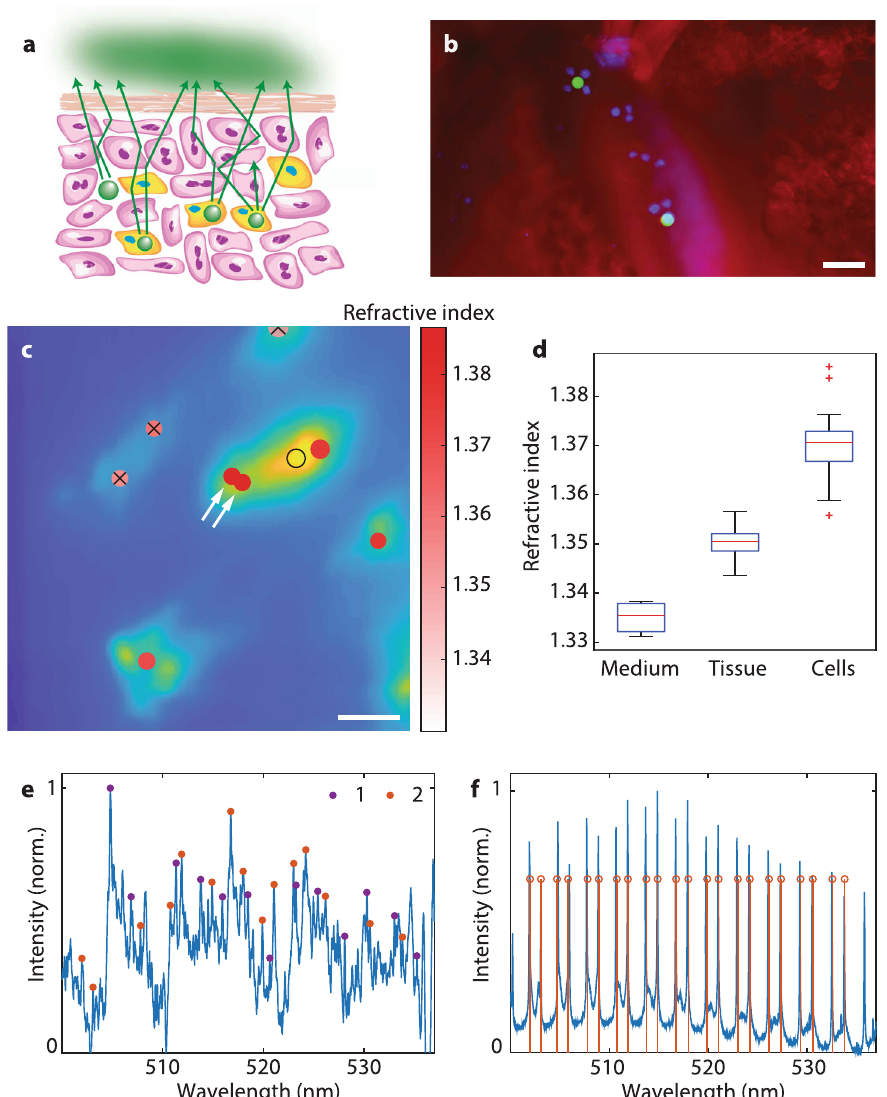
Fig. 4 Sensing and imaging in biological tissues. a Schematics of the experiment. Some cells injected into the skin tissue (yellow) contained the microcavities. There were also free microcavities in the interstitial space. b Fluorescence image of a cross-section of skin tissue containing the injected microcavities. Only the injected cells had their nuclei stained with a blue dye, while the cell membranes of the tissue cells were stained with a red dye. Scale bar, 50 μ m. c Reconstruction of microcavities injected below mouse skin represented in the same way as in Fig. 3f. The arrows denote two microcavities most likely located inside the same cell. The microcavity at the bottom of the image produced two intensity maxima due to tissue inhomogeneity, but the DSLI algorithm correctly identi fi ed this case as a single microcavity. Scale bar, 50 μ m. d The assessed refractive indices of the microcavity surroundings in three different environments: in the cell growth medium ( n = 20), injected below the skin of a mouse ( n = 15), or uptaken by the cells ( n = 25). The centerline, box limits, whiskers, and points indicate the median, upper and lower quartiles, extreme data points, and outliers, respectively. e Spectrum from two microcavities positioned below a 650 μ m thick slice of brain tissue. f The reconstructed peak wavelengths (red) and the emission spectrum of one microcavity measured without the brain slice